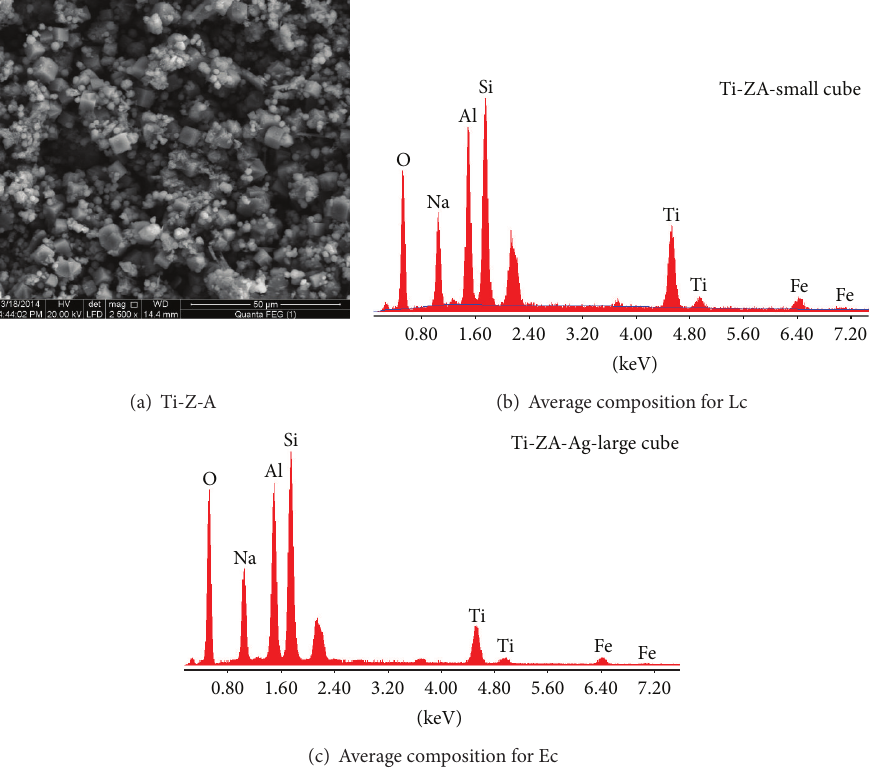
Figure 4: SEM micrographs for Ti-Z-A and its EDS analysis. Lc: late crystals = minute crystals. and Ec: early crystals = big crystals.